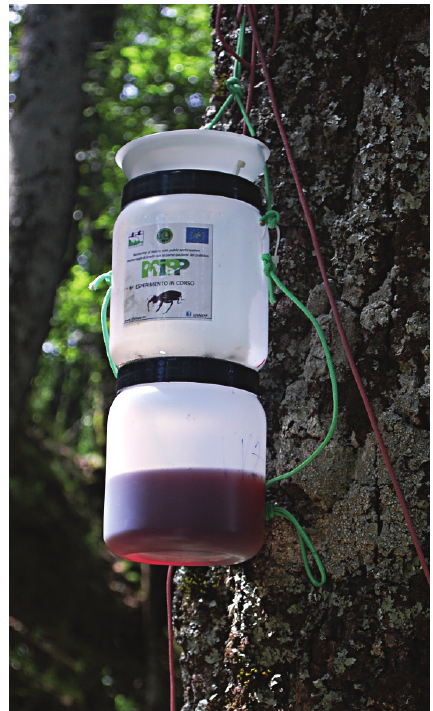
Figure 8. Baited trap for stag beetles (see construction details in the text) (photo by A.